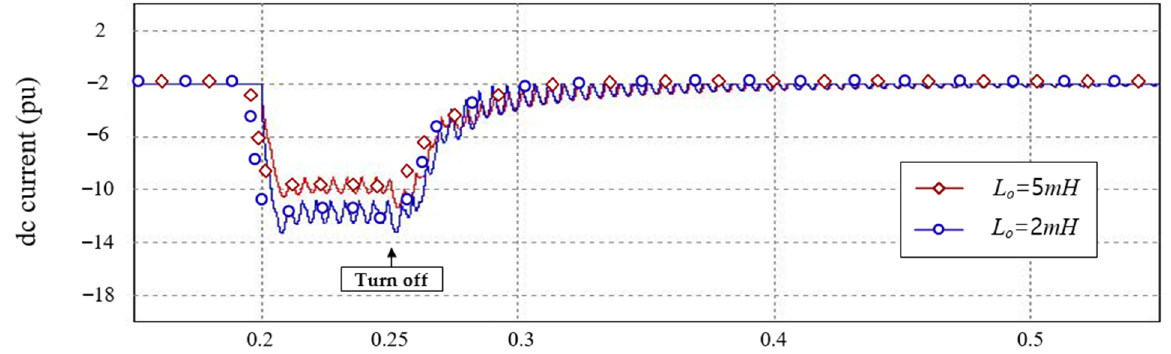
Figure 16. DC current under different arm inductance.